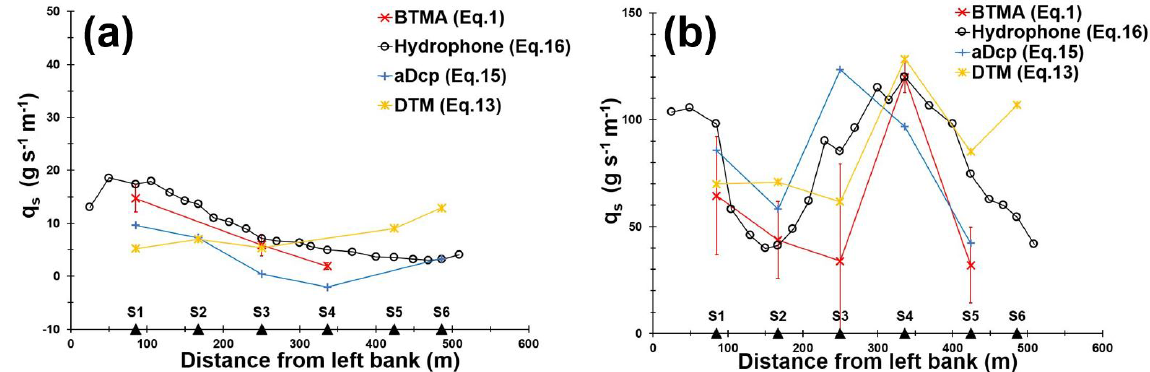
Figure 9. Lateral distribution of unit bedload rates assessed from different methods for two surveys performed: (a) 17 May 2018 ( Q = 604m 3 s − 1 ) and (b) 19 December 2019 ( Q = 2050m 3 s − 1 ),